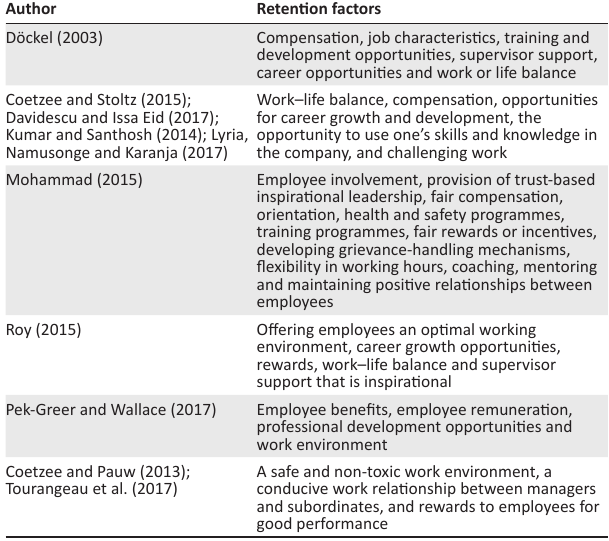
TABLE 1: Factors that enhance employee retention in